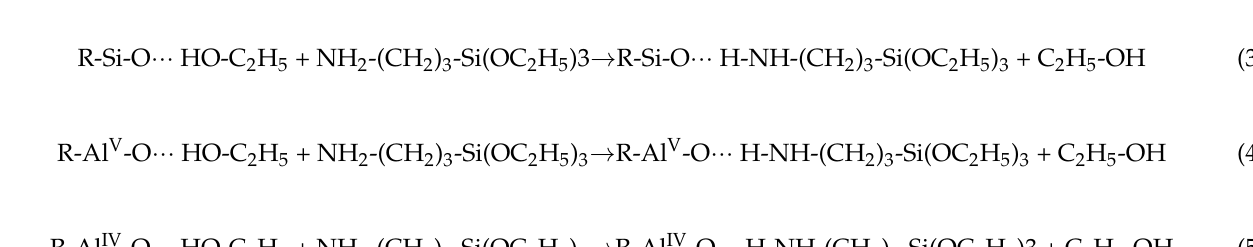
Figure 9. The change of activity index as modifier content. To further check the modification effect, the activity index was introduced, which reflects the impact of the surface modification on the surface properties of calcined kaolin. The higher the activation index, the better the compatibility of calcined kaolin with an organic matrix. Figure 9 shows that the activity index first increased dramatically, then drastically dropped with the increase in modifier content. It reaches a maximum of 76.7% when the modifier content is 2%, indicating that the modifier amount of 2% is a suitable modification ratio. Obviously, the surface modification improves the suspension and dispersion ability of calcined kaolin powder in water. Figure 10 shows the contact angle of water and n-heptane as a function of the modifier content on calcined kaolin surface changed. The contact angles of water on the sample tablet increased as the modifier content increased from 0% to 4%. The contact angle of n-heptane on the sample tablet showed a fluctuating decline when the modifier content increased. In comparison, according to the trend analysis of contact angle change, the modification slightly increases the lipophilicity and decreases the hydrophility when the modifier content is less than 4%. Figure 11 shows that the n-heptane and water vapor adsorption ratio also first increased, then decreased as the modifier content increased, indicating that the surface modification reduced the hydrophilicity of the sample. These results are consistent with the data in Figure 10. However, it does not seem to match the activity index change in Figure 9. Considering the agglomeration between the modified sample particles, the change of activity index is natural. The micropores between the particles on the surface of